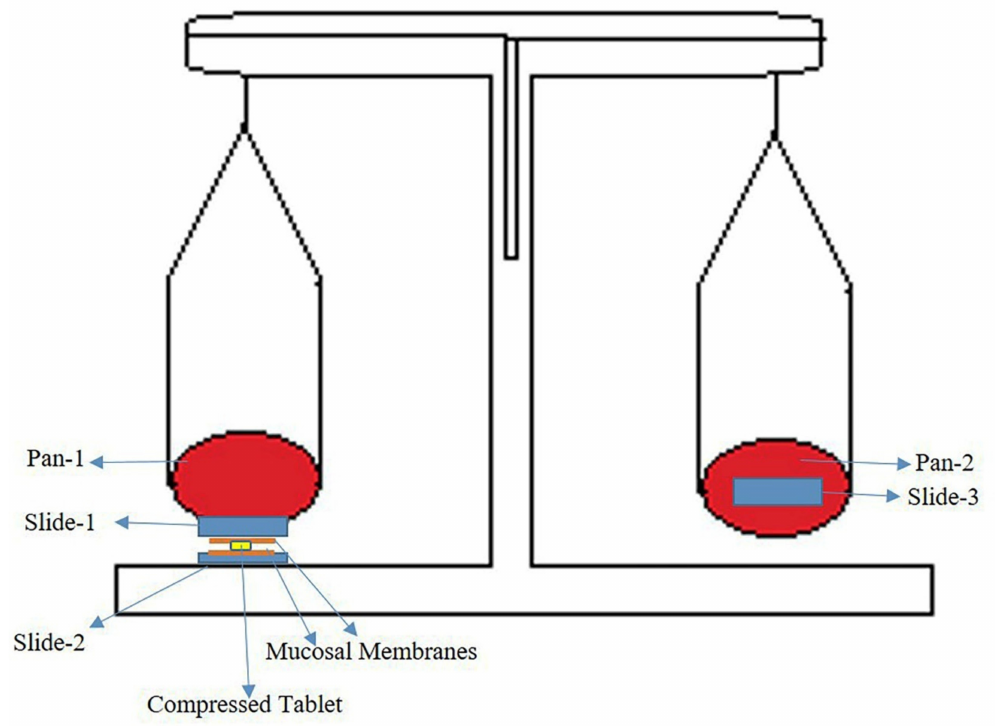
Figure 2. Graphical representation for the determination of mucoadhesion strength of tablets by sandwiching them between glass slides mounted with pieces of mucosal